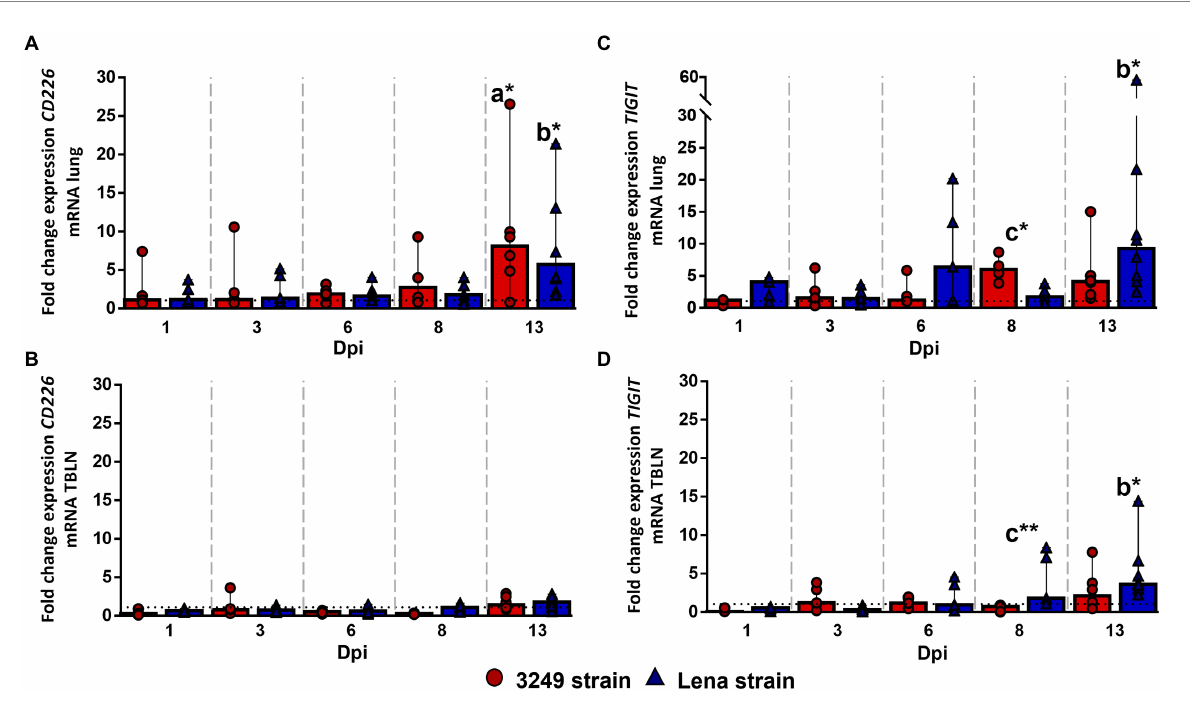
FIGURE 4 Relative mRNA expression of CD226 and TIGIT mRNA. Graphs show fold change expression of CD226 mRNA in lung (A) and tracheobronchial lymph node (TBLN) (B) , and of TIGIT mRNA in lung (C) and tracheobronchial lymph node (TBLN) (D) . Columns represent median with interquartile range (IQR). Individual values for each animal from low virulent 3249- (red circles) and virulent Lena- (blue triangles) infected animals are presented. Dashed line represents the expression of CD226 and TIGIT mRNA from control group in each organ. “a” indicates a significant difference between the 3249 and control groups, “b” between Lena and control groups and “c” between Lena and 3249 groups (* p ≤ 0.05 and ** p ≤ 0.01). Dpi, days